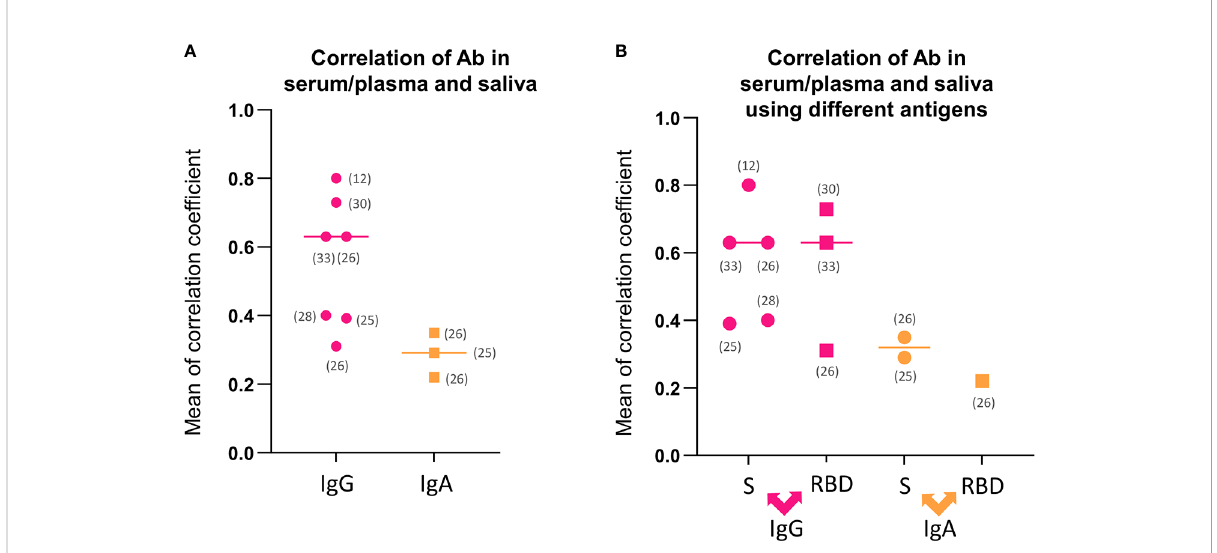
FIGURE 3 Correlations analysis regarding antibodies detection in serum/plasma and saliva. (A) Mean of correlation coef fi cients between antibodies detection in serum/plasma and saliva for IgG and IgA. (B) Mean of correlation coef fi cients between antibodies detection separated by antigen- antibody reaction for IgG and IgA. IgA, Immunoglobulin A; IgG, immunoglobulin G; RBD, receptor binding domain; S, spike protein; Total Ig, Total